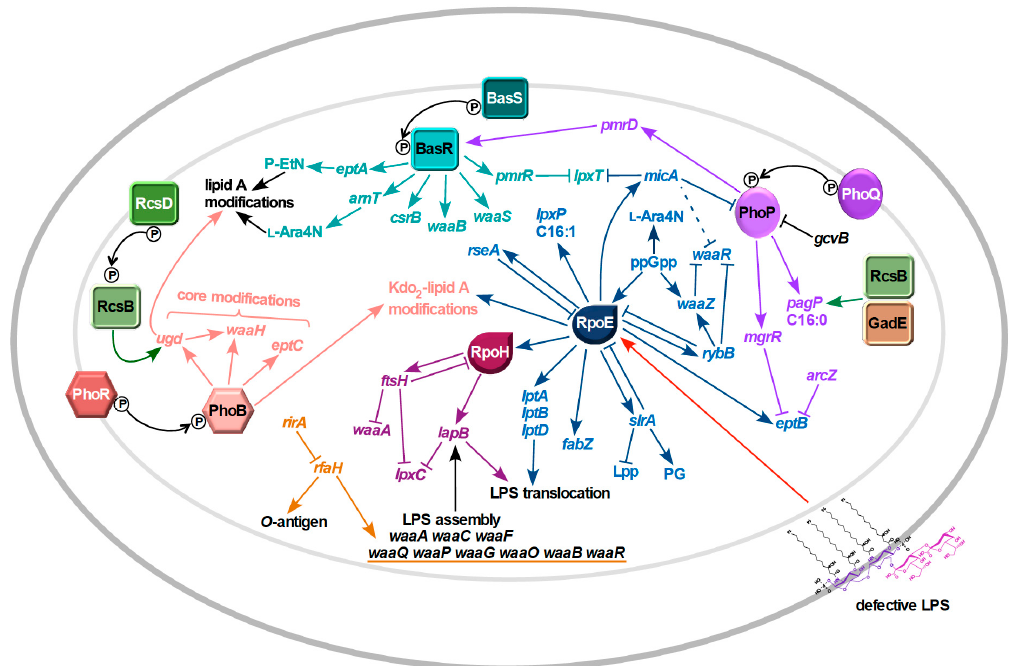
Figure 1. Networks of regulatory pathways that control the lipopolysaccharide (LPS) assembly and its non-stoichiometric modifications. The RpoE sigma factor responds to severe defects in LPS biosynthesis and is also required for transcription of genes involved in LPS biosynthesis / translocation and modifications via sRNAs like rybB and micA . RpoE also transcribes the slrA ( micL ) sRNA, which represses the Lpp synthesis and acts in a feedback manner to repress RpoE. Other regulatory controls involve two-component systems like BasS / R, PhoP / Q, PhoB / R and Rcs system, which are required for transcription of genes whose products are involved in lipid A and inner core modifications. The RpoH heat shock sigma factor transcribes lapB and ftsH genes, whose products control balanced biosynthesis of LPS and phospholipid by regulating LpxC levels. The unique transcriptional factor RfaH is required for overcoming antitermination, enhance transcriptional elongation and couple transcription/translation of waaQ and rfb LPS biosynthetic operons. The sRNA RirA binds to RfaH and abrogates its activity to maintain a balanced biosynthesis of